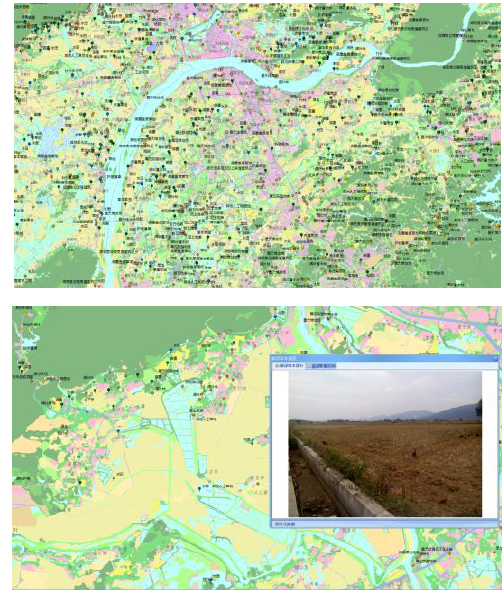
Figure 3. The spatial distribution of the RSAIS data and photo sample in two-dimensional display system